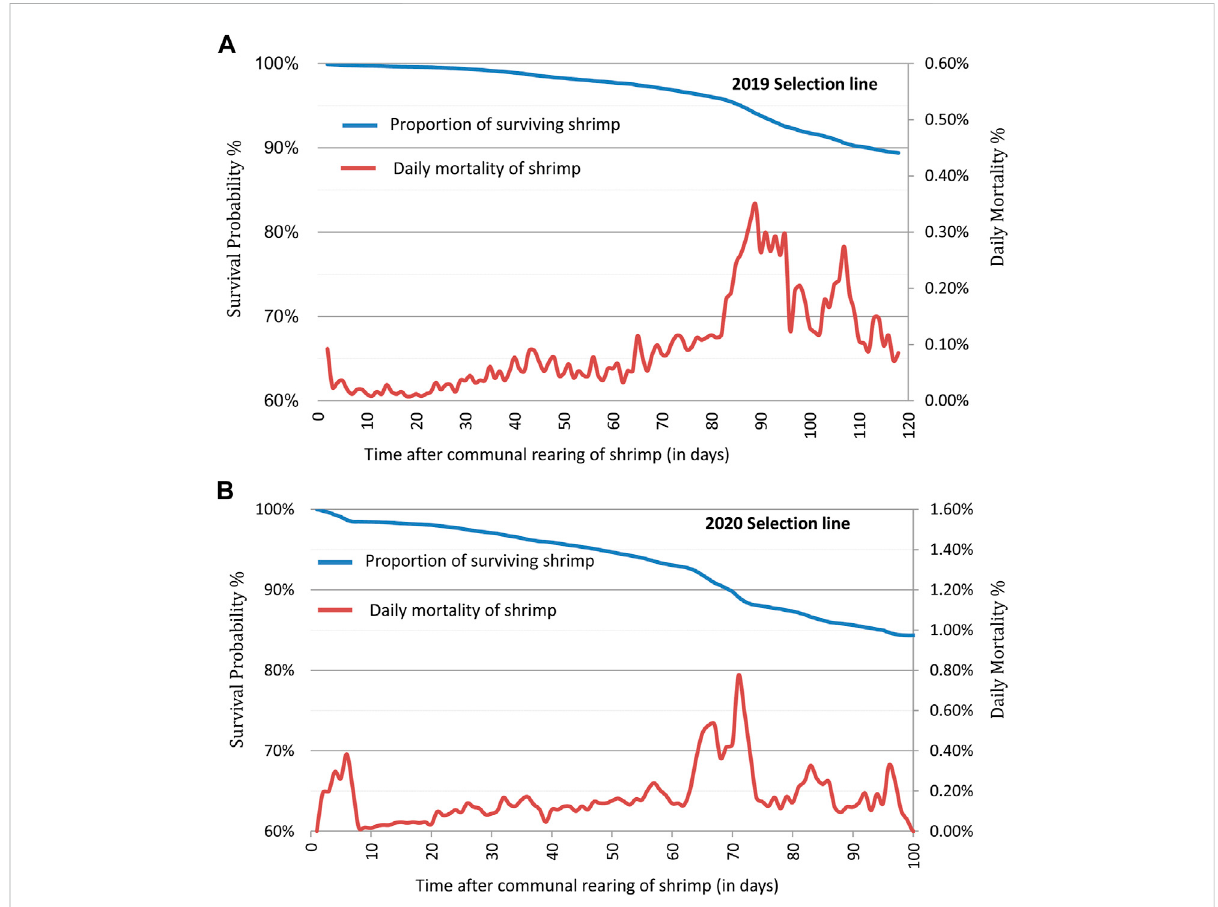
FIGURE 1 Kaplan-Meiersurvivalcurvesanddailymortalitychangesfortheshrimpbreedinglines: (A) 2019(BL2019)of243fullsibfamiliesand (B) 2020(BL 2020) of 238 fullsib